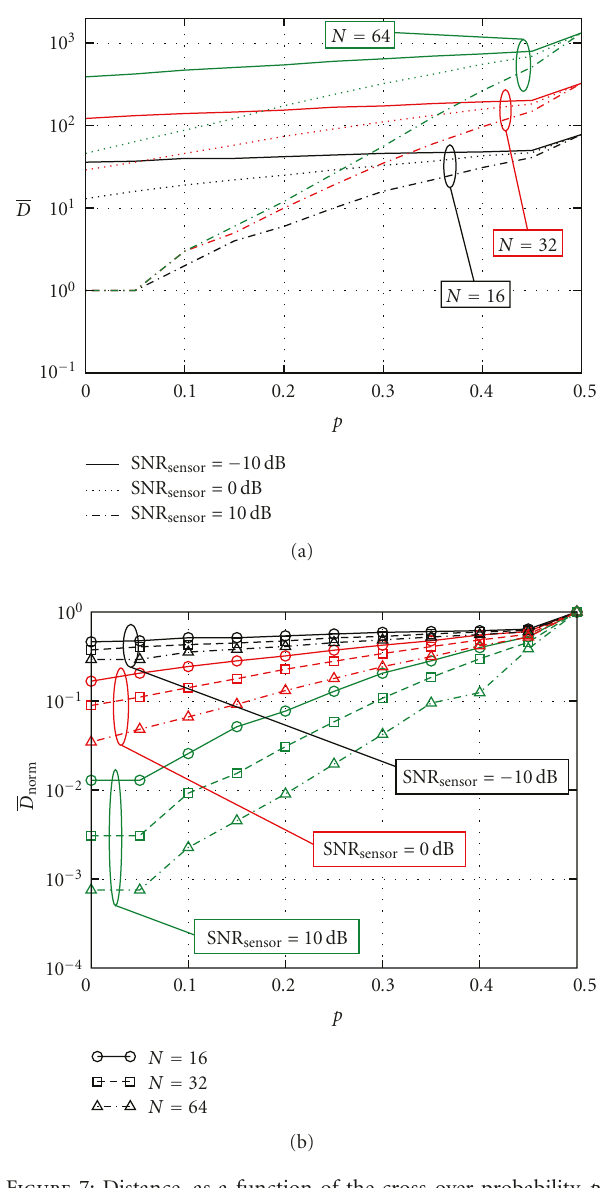
Figure 7: Distance, as a function of the cross-over probability p , in a scenario with binary quantization and simplified detection algorithm. Three values for the number of sensors are considered: (i) 16, (ii) 32, and (iii) 64. For a given number of sensors, three values for the sensor SNR are analyzed: (i) − 10dB, (ii) 0 dB, and (iii) 10 dB. In case (a), the distance is shown, whereas in case (b) the distance is normalized, for each value of N , to its corresponding maximum value ( D ( p = 0 . 5)).